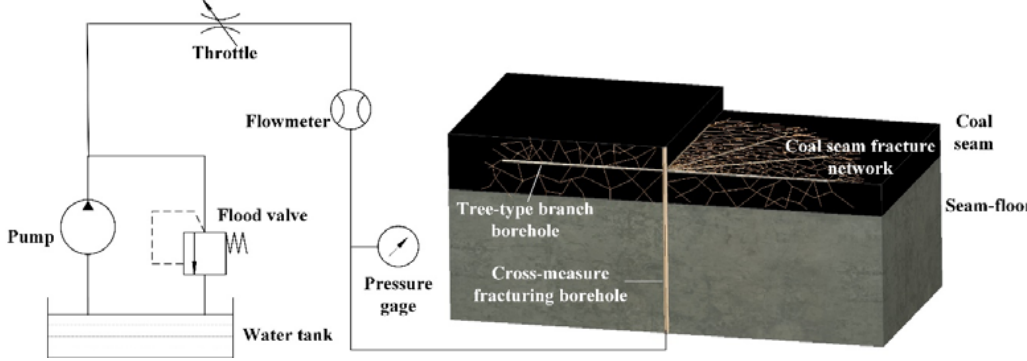
Figure 2. Schematic diagram showing the layout and implementation of the tree-type hydraulic fracturing system.